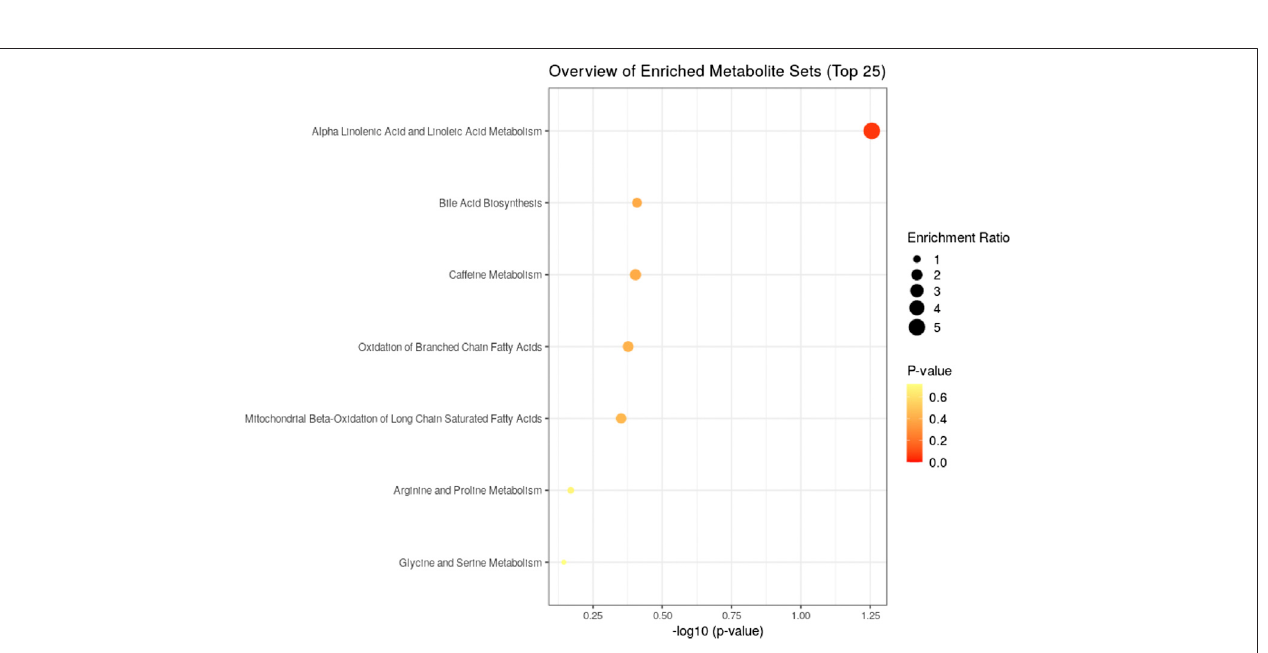
Frontiers in Pharmacology |